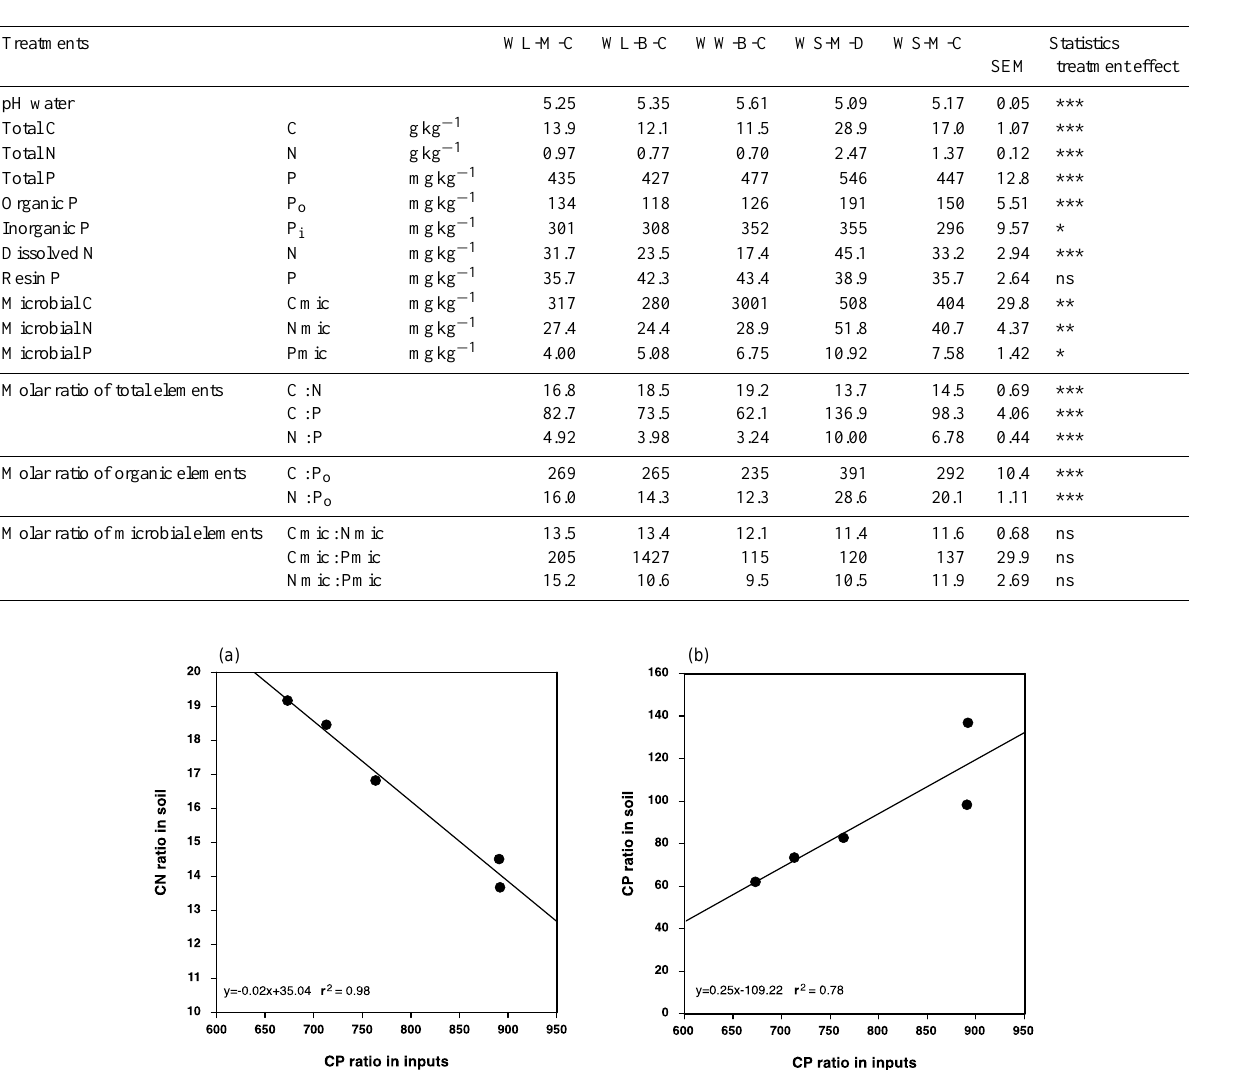
Table 5. Effects of different treatments on selected soil properties for the 0–5cm horizon and on C:N:P molar ratios in soil sampled in 2005 at Wagga Wagga, Australia (all data are from Bünemann et al., 2008b).